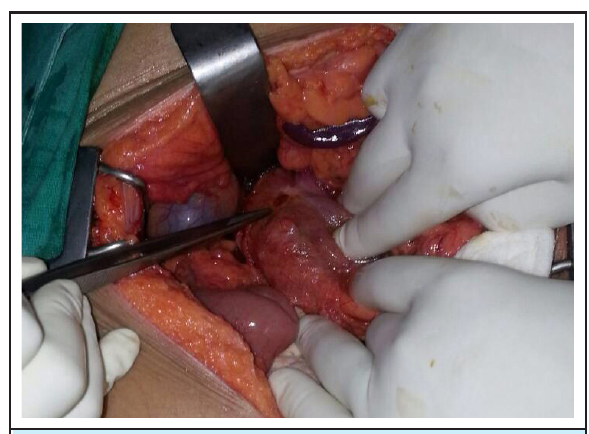
Figure 2. Intra-operative findings of perforation in anterior wall of the first part of the